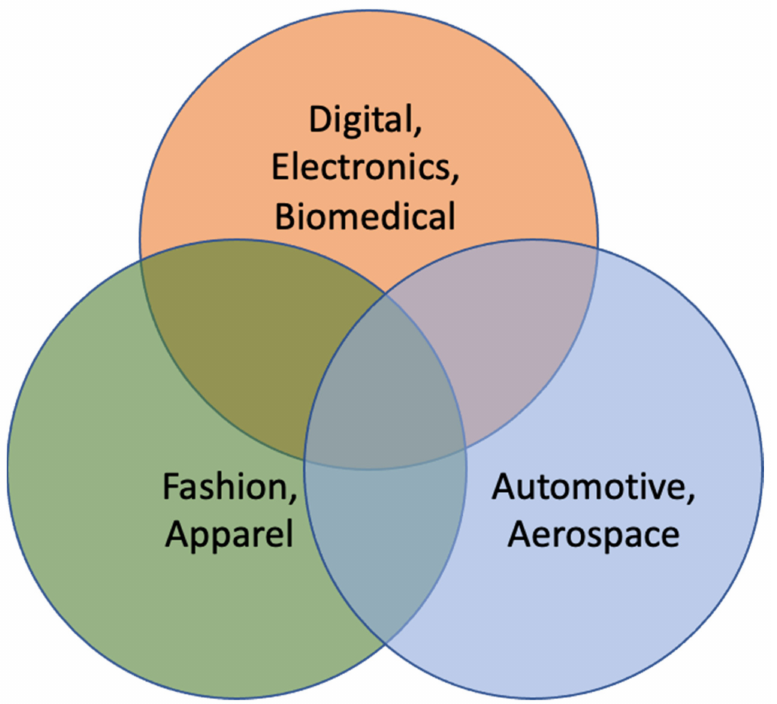
Figure 15. Present and future applications of 4D printing in different sectors of industry. Four-dimensional printing grants the freedom to change its shape over time to 3D printed parts and objects. Printed components and structures could change shape due to a difference in temperature, air pressure, pH conditions, or other environmental